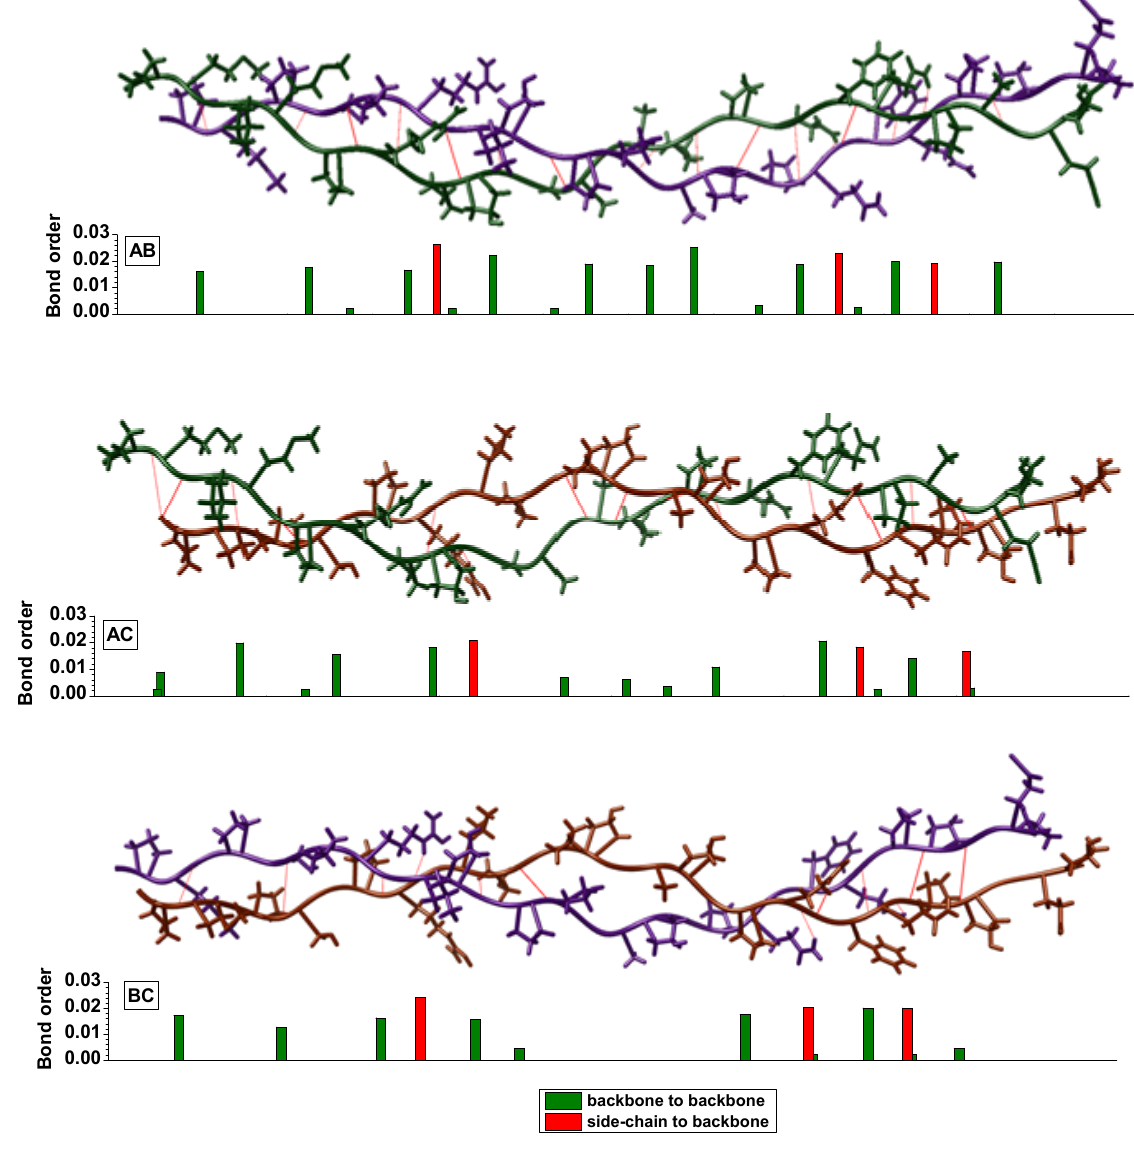
Figure 7. (Color on-line) Calculated H-bond location and relative strength between pairs of chains [ A (green), B (purple), and C